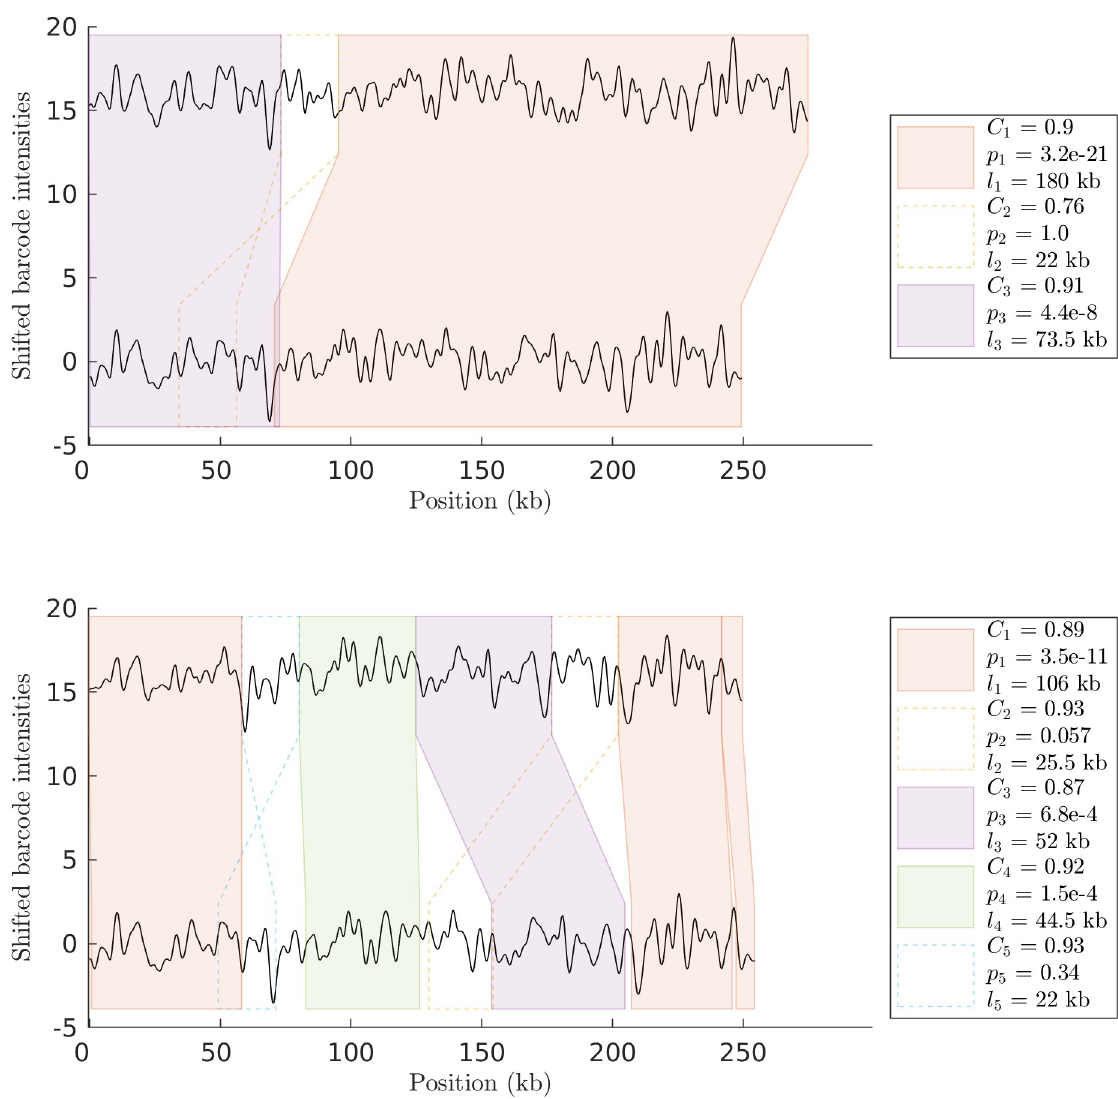
Fig 3. SV-detection for noisified random SV barcodes. (Top) HMM output for comparison of two noisified random SV barcodes with a single 50 pixel (25 kb) insertion. (Bottom) HMM output for comparison of two noisified random SV barcodes with a 50 pixel (25 kb) inversion and a 50 pixel (25 kb) translocation. Sub-barcode pairs that did not pass the p-value threshold are visualized in dashed boxes. In the tables next to each figure, dist scores for sub-barcodes C was here set to